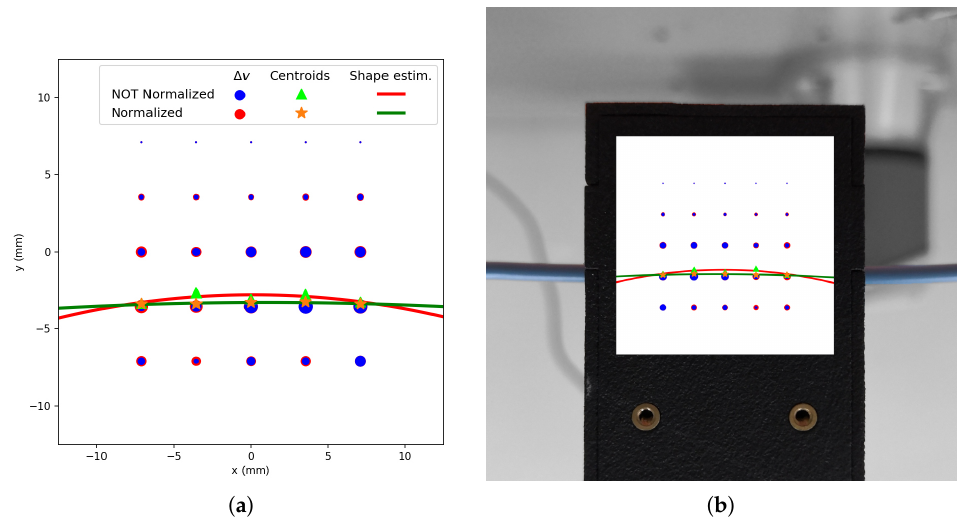
Figure 8. Comparison between shape estimations using not-normalized and normalized values: tactile maps with shape estimations ( a ) and estimations superimposed on the actual finger with the grasped wire ( b ).